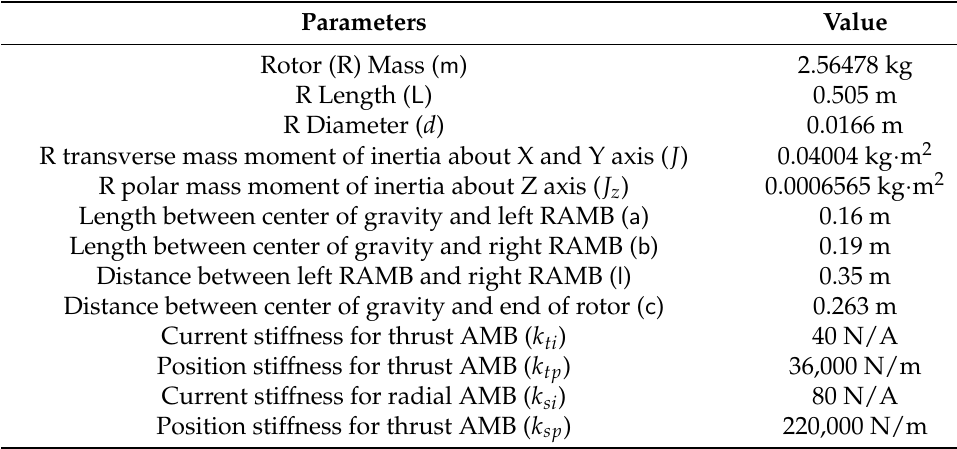
Table 1. Physical parameters of five DOF AMB system [29,59].